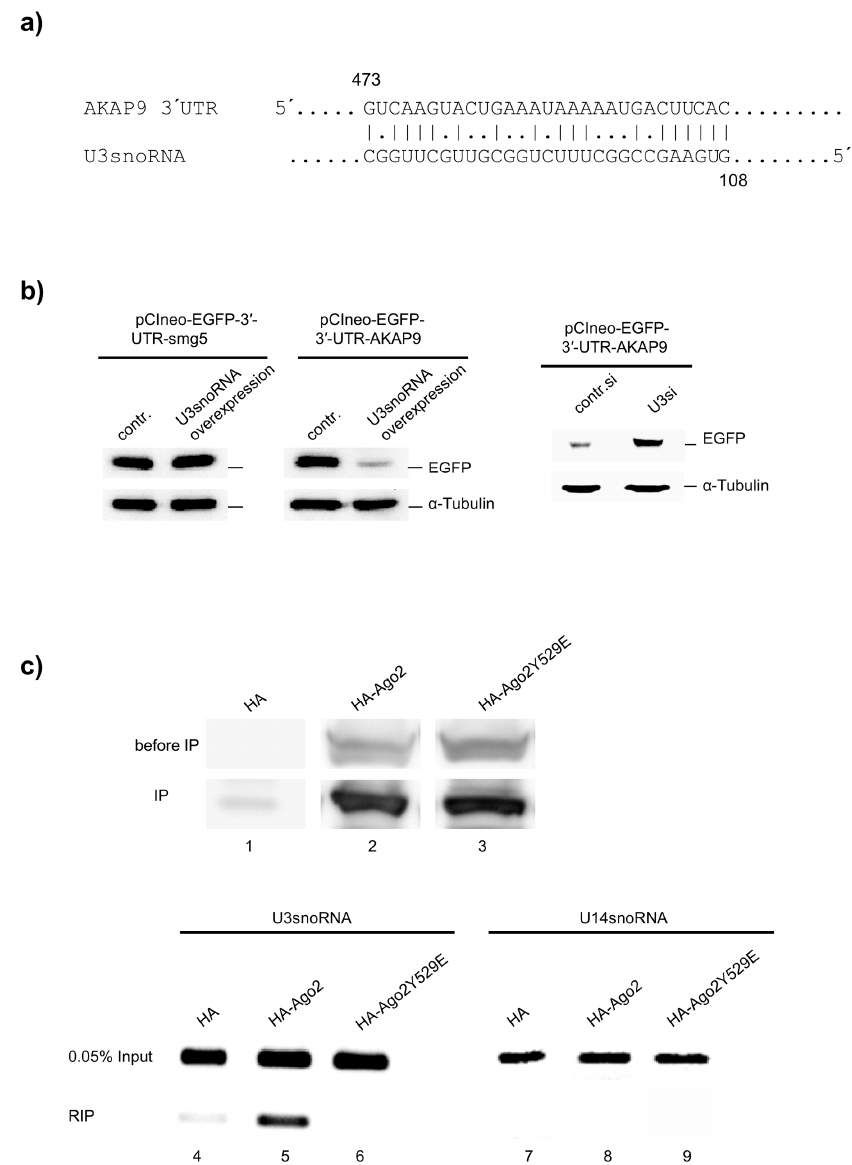
Figure 7. Expression regulation of a reporter construct containing the 3 (cid:48) untranslated region (UTR) of the A-kinase anchor protein 9 (AKAP9) mRNA by U3snoRNA and binding of U3snoRNA to Argonaute 2 (Ago2); ( a ) Predicted complementary sequences of U3snoRNA and AKAP9 3 (cid:48) UTR; ( b ) Control of the expression of enhanced green fluorescent protein (EGFP) by U3snoRNA via the 3 (cid:48) UTR of AKAP9 mRNA linked to the EGFP-encoding cDNA (pCIneo-EGFP-3 (cid:48) -UTR-AKAP9). The 3 (cid:48) UTR of smg5 mRNA linked to the EGFP-encoding cDNA (pCIneo-EGFP-3 (cid:48) -smg5) was used as a control. We show the Western blot analysis of EGFP expressed from the respective constructs on dependence of U3snoRNA overexpression (left) or knockdown of U3snoRNA (right). α -Tubulin served as a loading control. Overexpression and knockdown of U3snoRNA is shown in figures 6a and S1a; ( c ) Binding of U3snoRNA to Ago2. Human influenza hemagglutinin tagged Ago2 (HA-Ago2), its siRNA-binding deficient mutant (HA Ago2_Y529E), or only the HA-tag (HA) were expressed from respective plasmids for 72 h in HEK239 cells and resultant cell extracts immunoprecipitated with anti-HA antibodies. An aliquot of the cell extracts (0.05%, before immunoprecipitation (IP)) as well as an aliquot (10%) of the IP were analyzed by Western blotting using anti-HA antibodies (lanes 1–3). The remaining immunoprecipitates were analyzed for co-immunoprecipitated U3- (lanes 4–6) and U14snoRNA (lanes 7–9) by RT-PCR. An aliquot of cell extracts was co-analyzed for the snoRNAs (0.05%